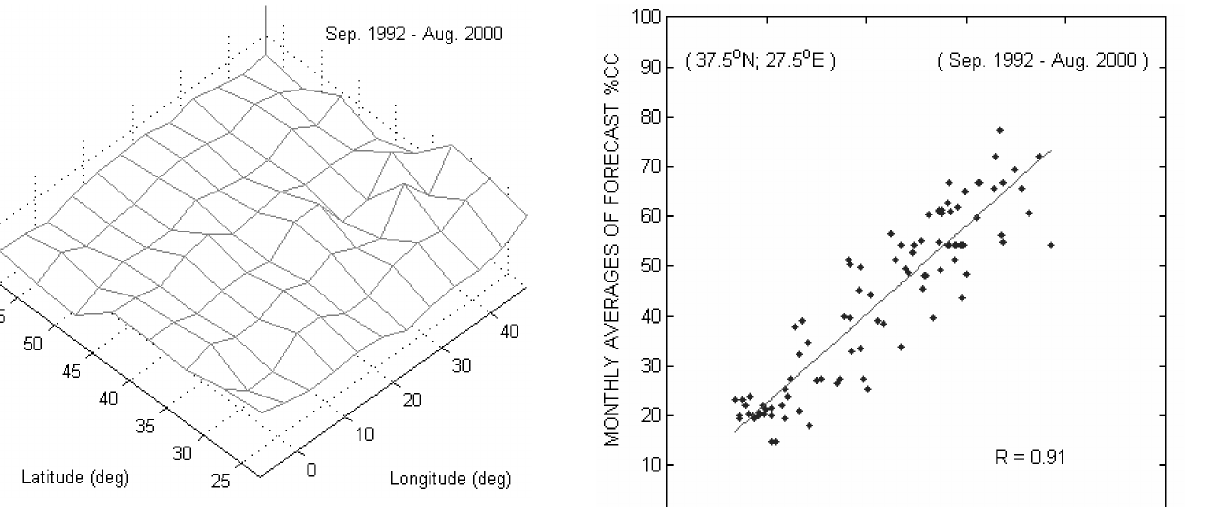
Fig. 8. The map of the absolute error values on the %CC versus latitude and longitude grids.